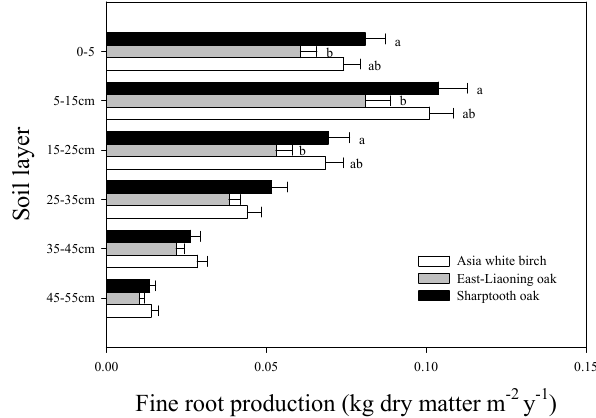
Fig. 6. Vertical distribution of fine root production in Asia white birch and East-Liaoning oak forests of warm temperate zone and Sharptooth oak forest of sub-topical zone. Horizontal bars indicate standard errors of means ( n =5). Different letters within a soil layer are significantly different ( P < 0.05) according to the least signifi- cant difference test. Absence of letters implies that no significant differences were